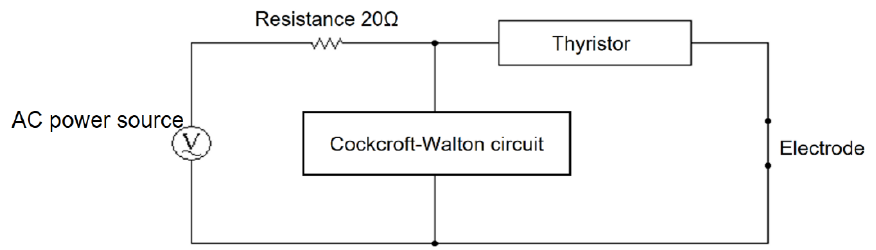
Figure 1. Power supply circuit diagram for shock wave generation.